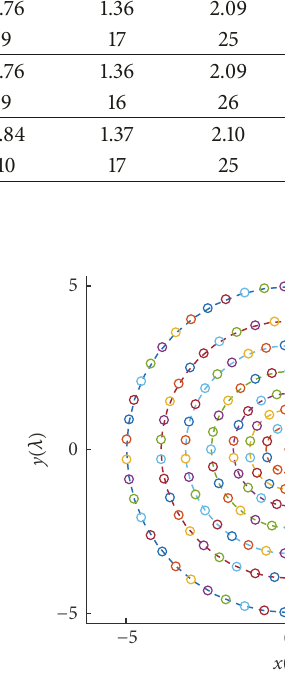
Figure 4: The diagram of element